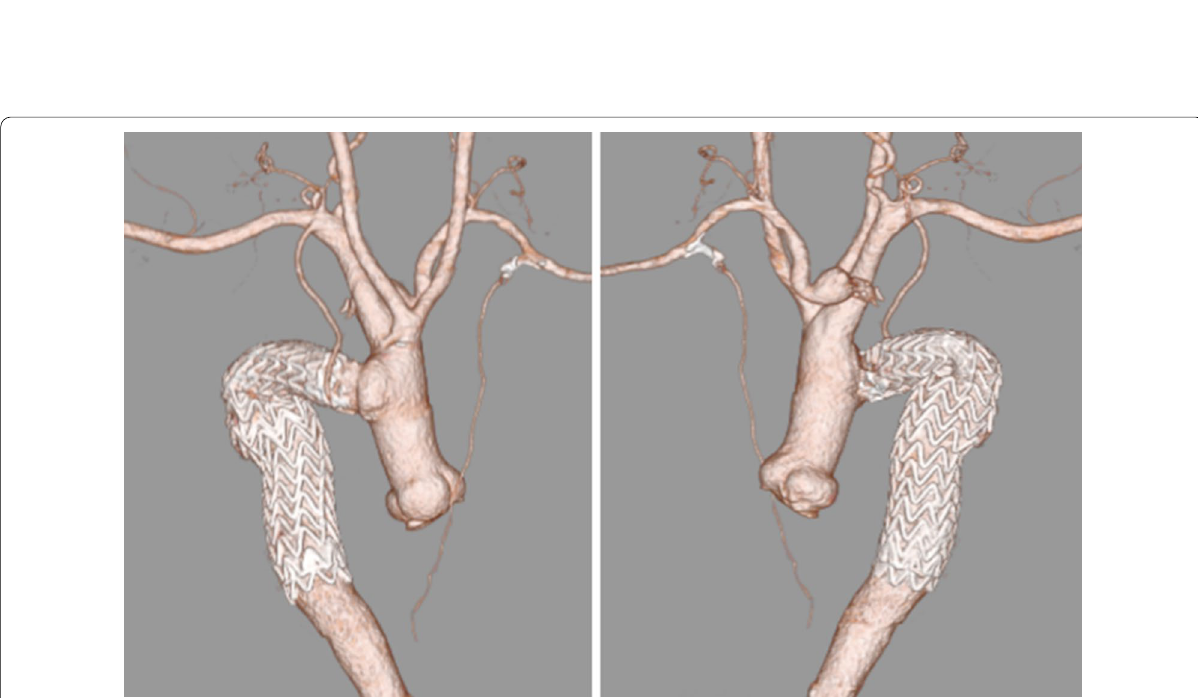
Fig. 3 Postoperative computed tomography with 3D reconstruction. Anterior ( a ) and posterior ( b ) views show no contrast medium